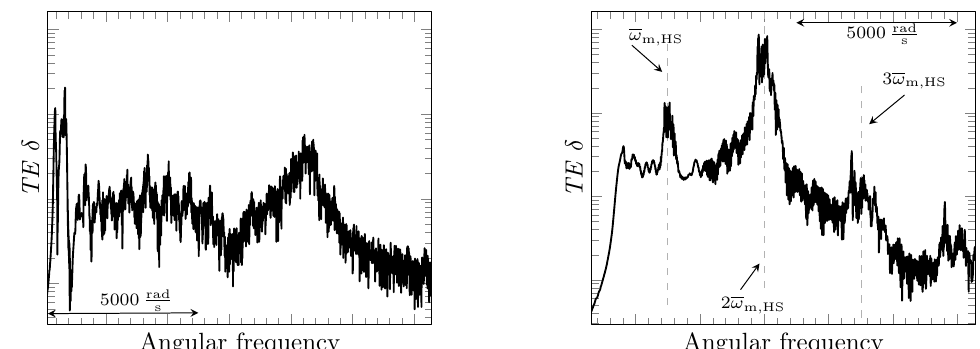
Figure 16. Angular frequency spectra of the transmission error δ for the IS ( left ) and HS stage ( right ), with vertical lines indicating the average mesh frequency of the HS stage ω m,HS and its